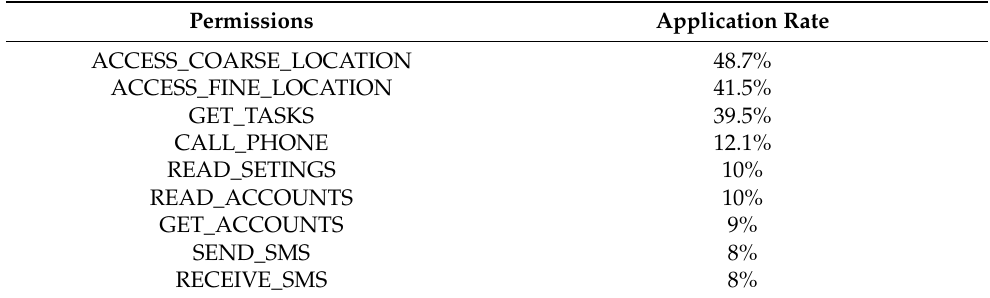
Table 3. The proportion of privacy rights.